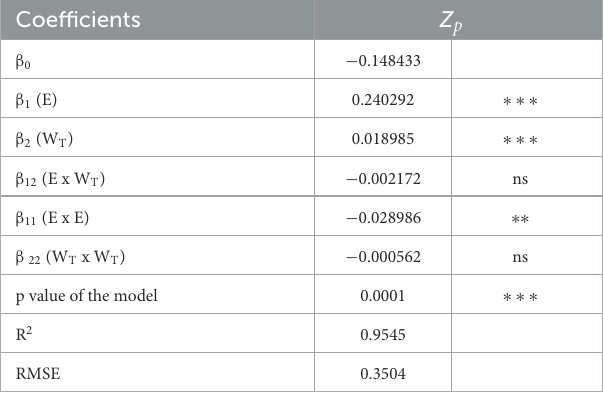
TABLE 4 Analysis of variance (ANOVA) of the second order polynomial equation describing the influence of PEF process parameters on the cell disintegration index ( Z p ) of grape pomace tissues.